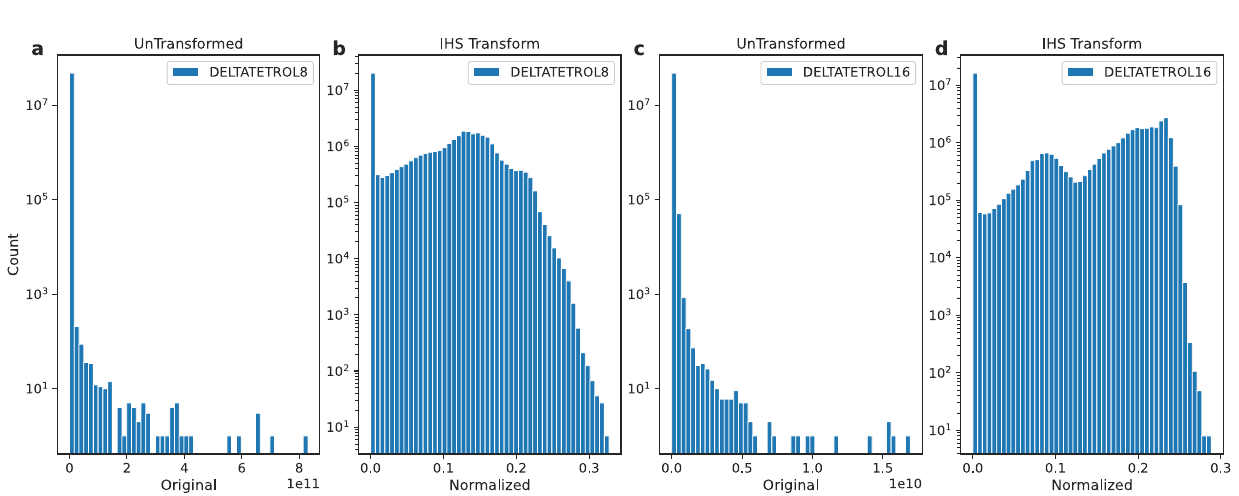
Fig. 7 Training data transformation using IHS. The inverse hyperbolic sine (IHS) transform with the min-max normalization of the output IEPOX-SOA fl uxes greatly decreases the number of zeroes in the training dataset, changes the target distribution, and makes the training of DNN model feasible. a Original distribution of Tetrol fl ux of bin 8. b IHS-transformed distributions of Tetrol fl ux bin 8. c Original distribution of Tetrol fl ux Bin 16. d IHS-transformed Tetrol fl ux Bin 16 distribution.